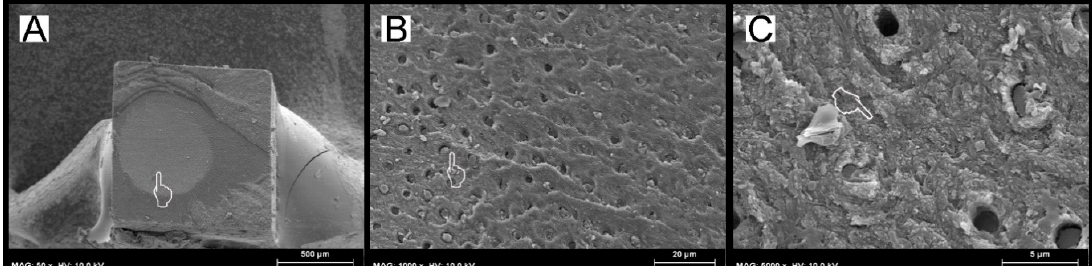
Figure 2. SEM Fractographic analysis after load-cycle aging. ( A ) SEM fractography of a specimen created with SCU applied in ER mode and restored with RC showing a characteristic failure in mixed mode. The finger pointer indicates a brighter area of greater and more evident aging (pointer), which was probably induced by the cycling load. However, when we observed that specific area at higher magnifications ( B ), it was possible to observe that the fracture occurred underneath the hybrid layer (pointer), which is characterized by the presence of mineralized dentine (pointer), with tubules totally obliterated by resin tags and with no presence of demineralized exposed collagen fibrils ( C ).